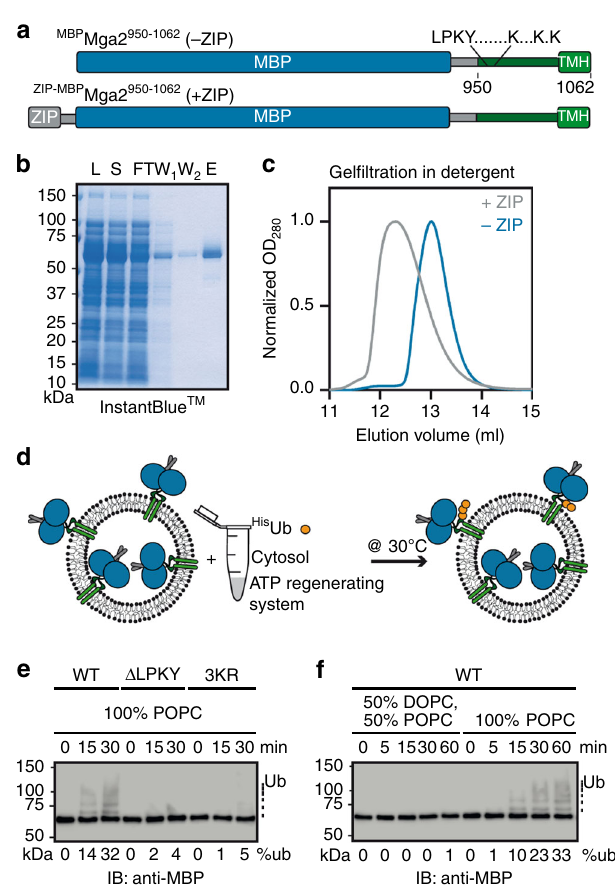
Fig. 2 An in vitro sense-and-response system for membrane lipid saturation. a Schematic representation of the sense-and-response constructs. The fusion proteins are composed of the maltose-binding protein (MBP, blue) and Mga2 950 – 1062 (green) with the Rsp5-binding site (LPKY), three lysine residues as targets of ubiquitylation (K 980 , K 983 , and K 985 ), a predicted disordered juxtamembrane region, and the C-terminal TMH. An optional N-terminal leucine zipper derived from Gcn4